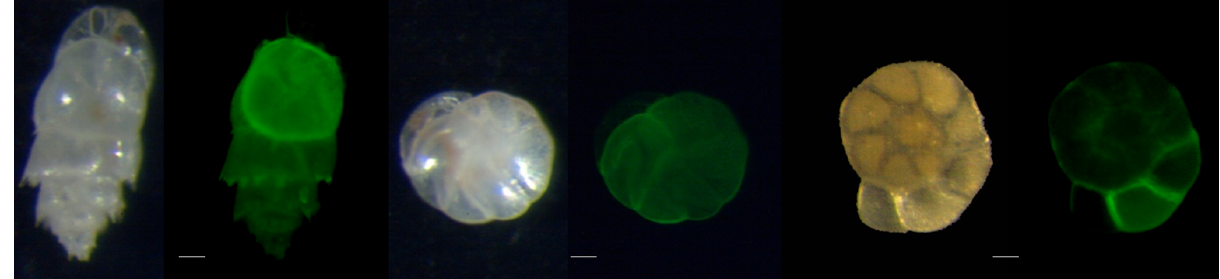
Figure 4. Example of new chambers, not calcein labelled, produced during the experiment under anoxic conditions. (a) Ammonia tepida from layer 4 (2.3–3.3cm) under natural light (left) and epifluorescence (right); (b) Bulimina marginata from layer 3 (1.3–2.3cm) under natural light (left) and epifluorescence (right); (c) Cassidulina laevigata from layer 4 (2.3–3.3cm) under natural light (left) and epifluorescence (right). Photo exposure time: 1 / 2 . 5 00 . Scale bar is